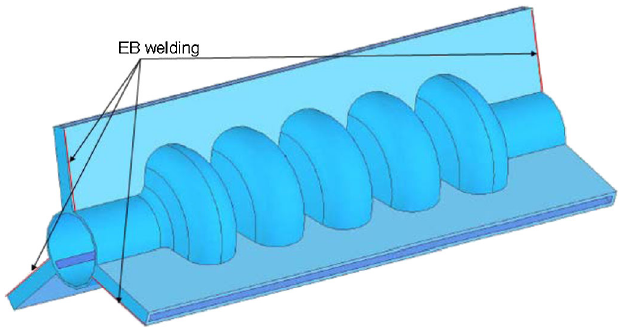
FIG. 3. Parameters for the center cell shape of the